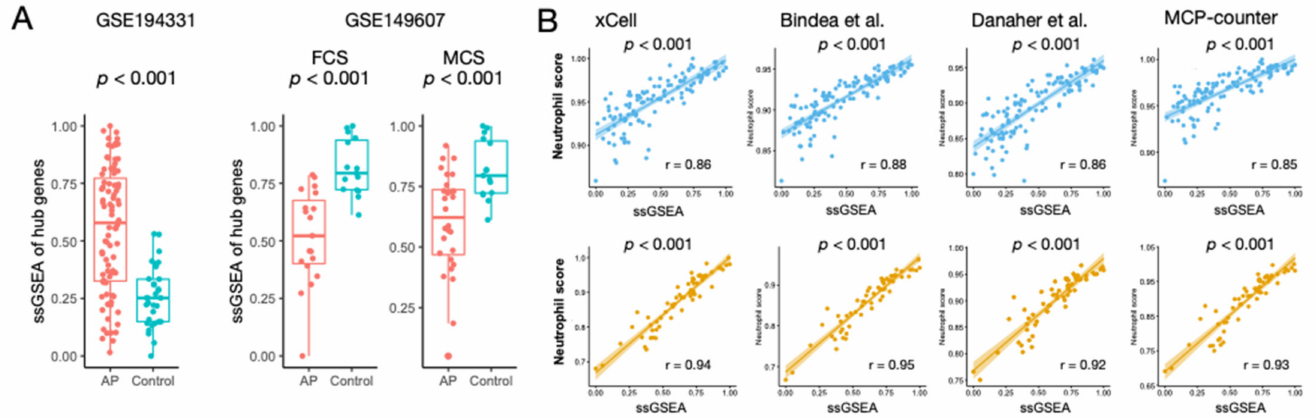
Figure 4. Regulatory activity of the hub genes in AP. ( A ) Box plots show differences in single-sample GSEA (ssGSEA) scores between AP and control in GSE194331 and GSE149607. Wilcoxon’s rank sum test P values are shown. ( B ) Scatter plots show Spearman’s correlation between ssGSEA scores and the estimated neutrophil infiltrations in GSE194331 and GSE149607. Gene signatures used for estimating the neutrophil infiltration are based on xCell, Bindea et al., Danaher et al., and MCP- counter. Correlation coefficients (r) are shown, and significance of correlation was obtained using Spearman’s